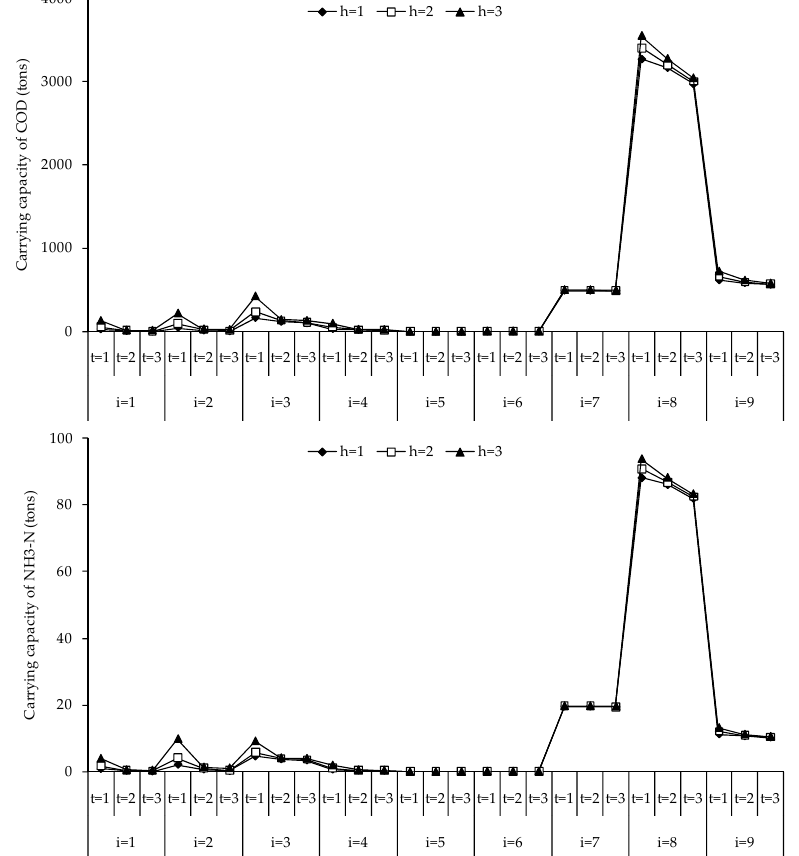
Figure 3. Environmental carrying capacities of chemical oxygen demand (COD) and NH 3 -N in the Yitong River.